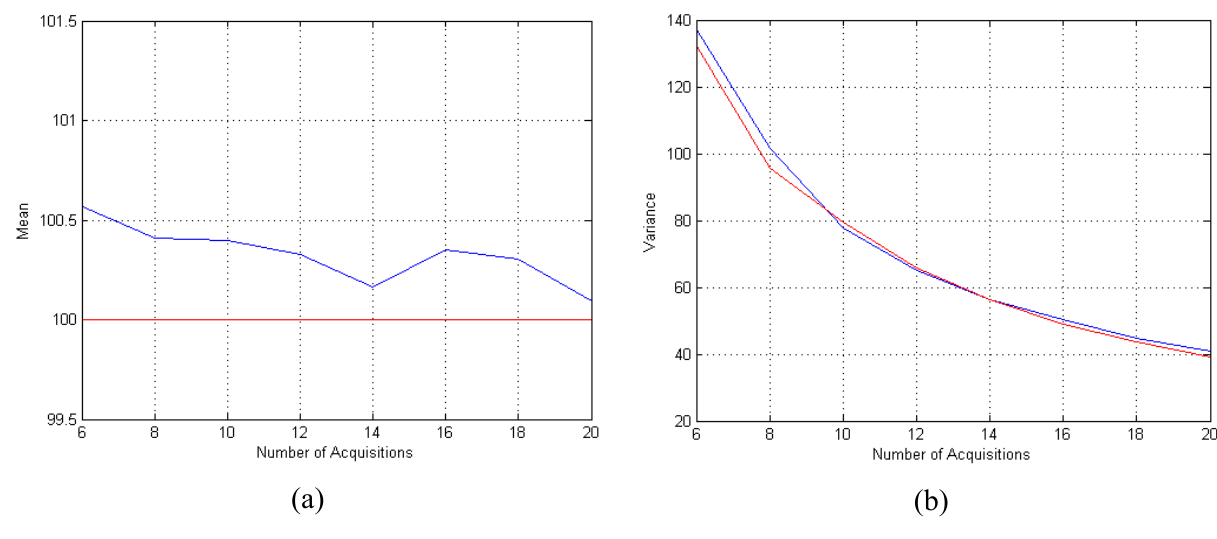
estimator for different number of available Figure 5 . Performances of the T 2 complex-valued data. (a) Mean behavior (the mean is plotted in blue and the true value is plotted in red) and (b) variance behavior (the variance is plotted in blue and the CRLB are values plotted in red). The results are obtained using SNR = 4,  = 60° and N T E equispaced in the interval [50 350]